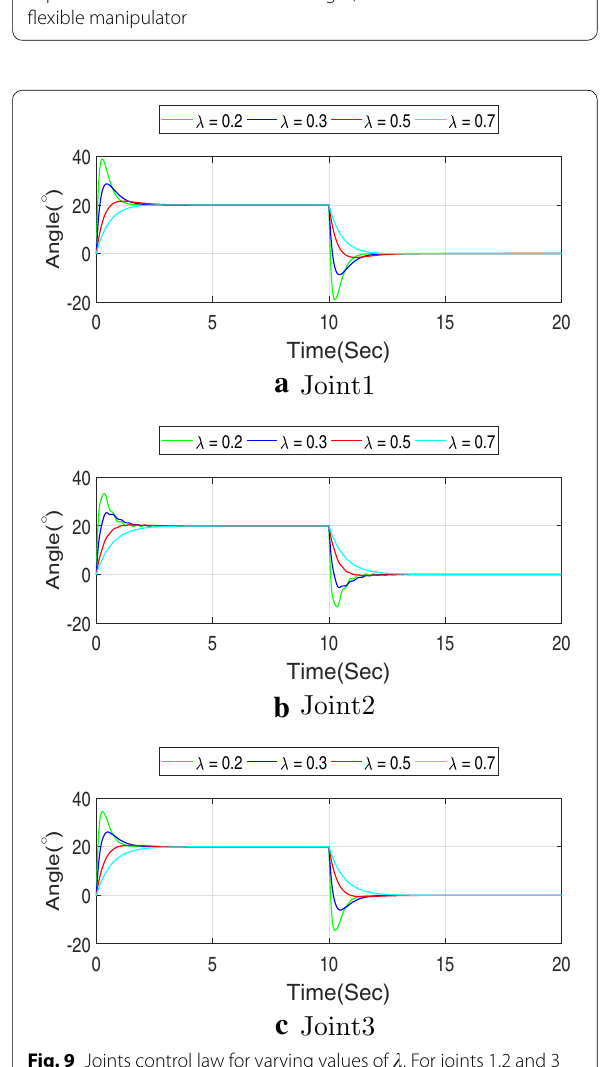
Fig. 9 Joints control law for varying values of (cid:31) . For joints 1,2 and 3 and for varying values of (cid:31) , the figure shows the evolution of the joint control law